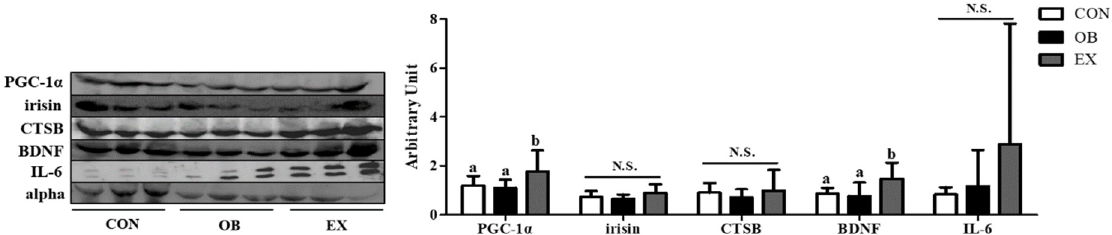
Figure 7. Effects of resistant exercise on plasma cognitive function-related myokines in sarcopenic obese mice . Values are means ± SD ( n = 5~6). Mean values with the same superscript letter (a and b) are not significantly different ( p < 0.05). BDNF: brain-derived neurotrophic factor, PGC-1 α : peroxisome proliferator-activated receptor-gamma coactivator 1-alpha, CTSB: cathepsin B, IL-6: interleukin-6. N.S.: no significance.